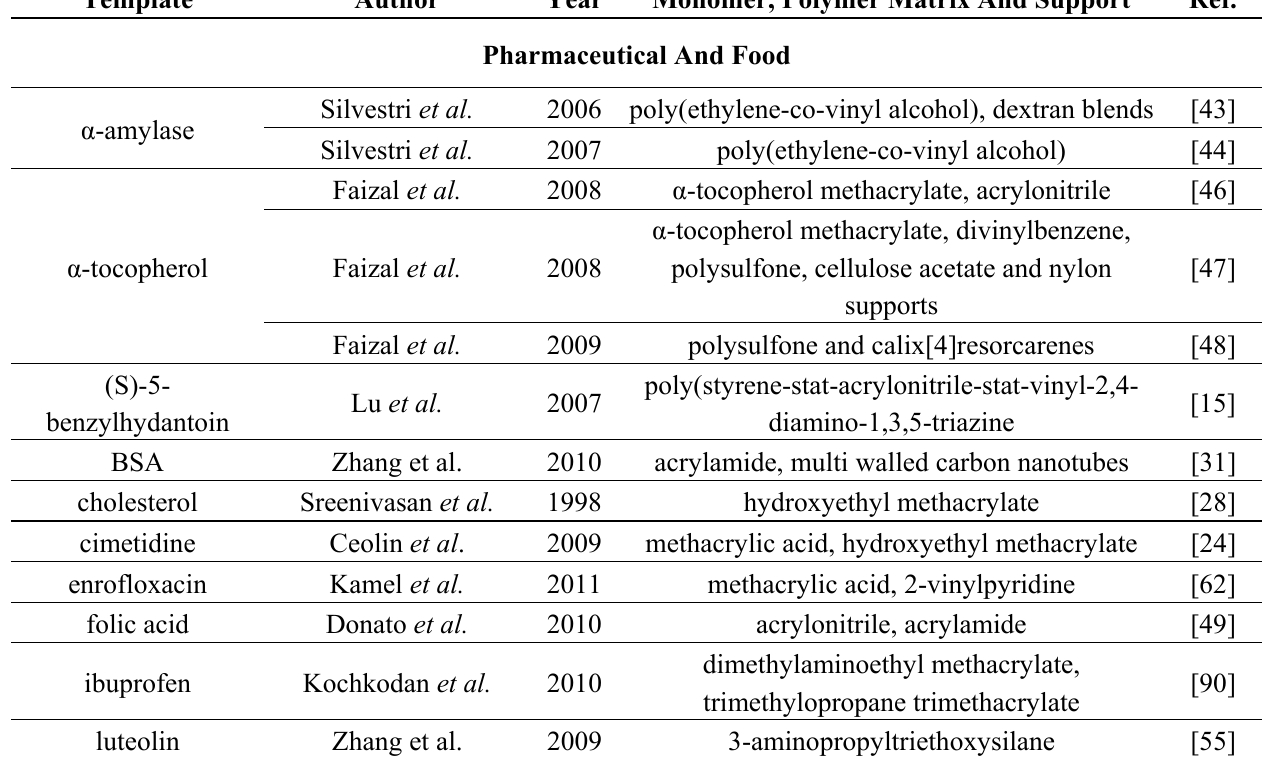
Table 2. A summary of MIMs and